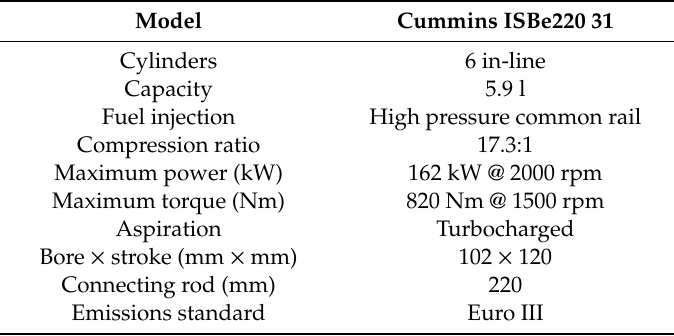
Table 1. Specifications of the experimental engine utilised in the current study